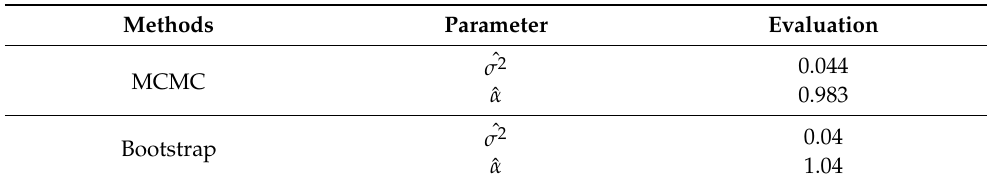
Table 3. The estimation results of unknown